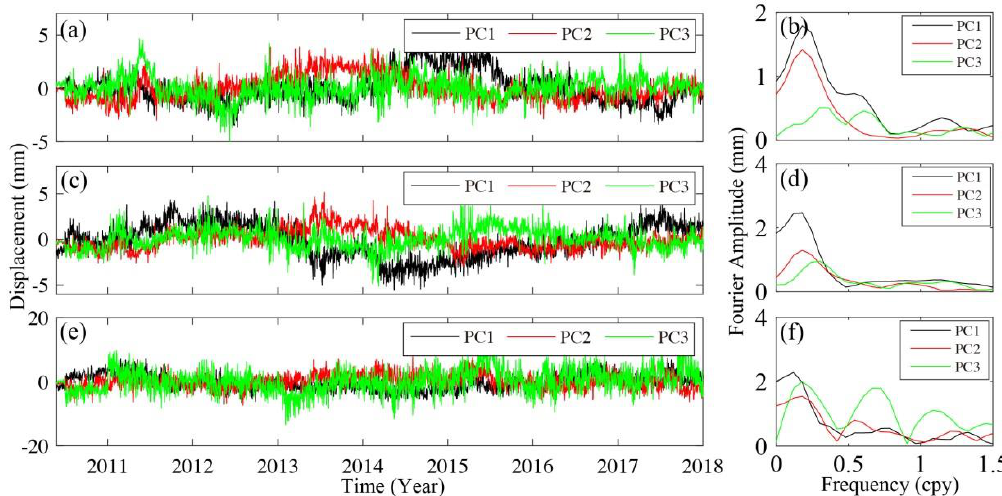
Figure 5. Time series of the common mode components (scaled PC1 through PC3) decomposed by principal component analysis (PCA) from the regional long-term GPS time series. ( a - f ) are the PCs on the North, East, and vertical components, and the corresponding Fourier amplitude spectra of the first three PCs on the North, East, and vertical components, respectively.